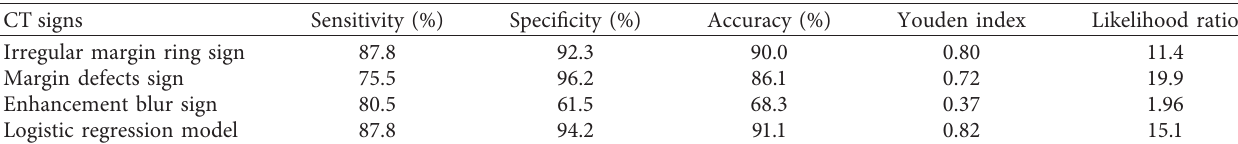
Table 4: Diagnostic efficacy of various